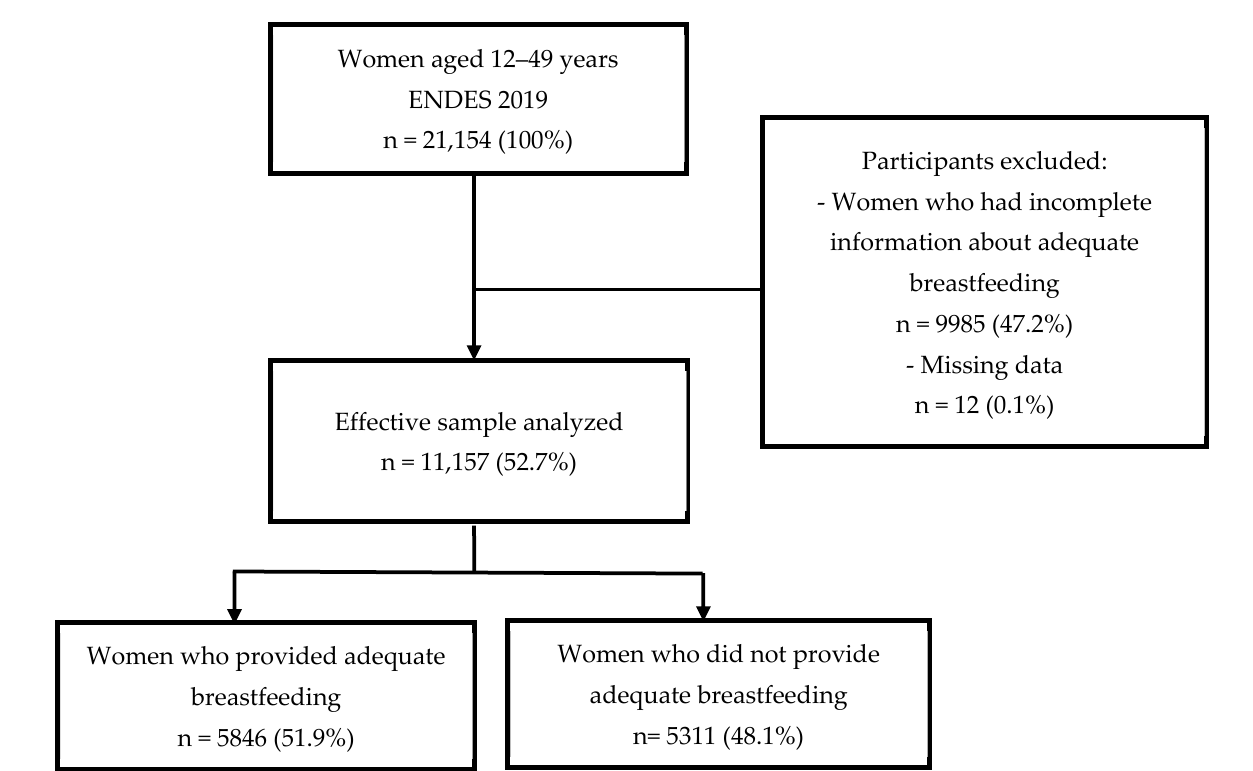
Figure 1. Flowchart of the selection of the study sample.